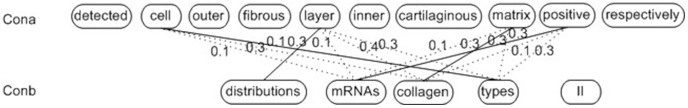
An example of the maximum matching in the bipartite graph.
Cona and Conb are two different contexts. The maximal matching between Cona and Conb is flagged with solid lines. Edges with weight 0 are bypassed and all weights are rounding in this figure.